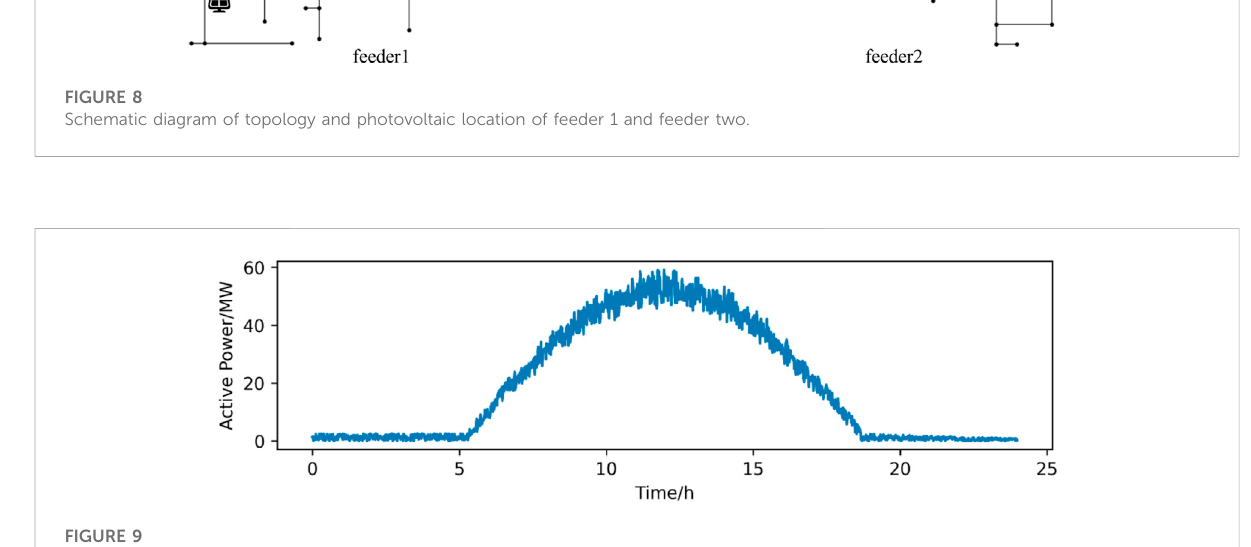
FIGURE 9 Standard curve of photovoltaic